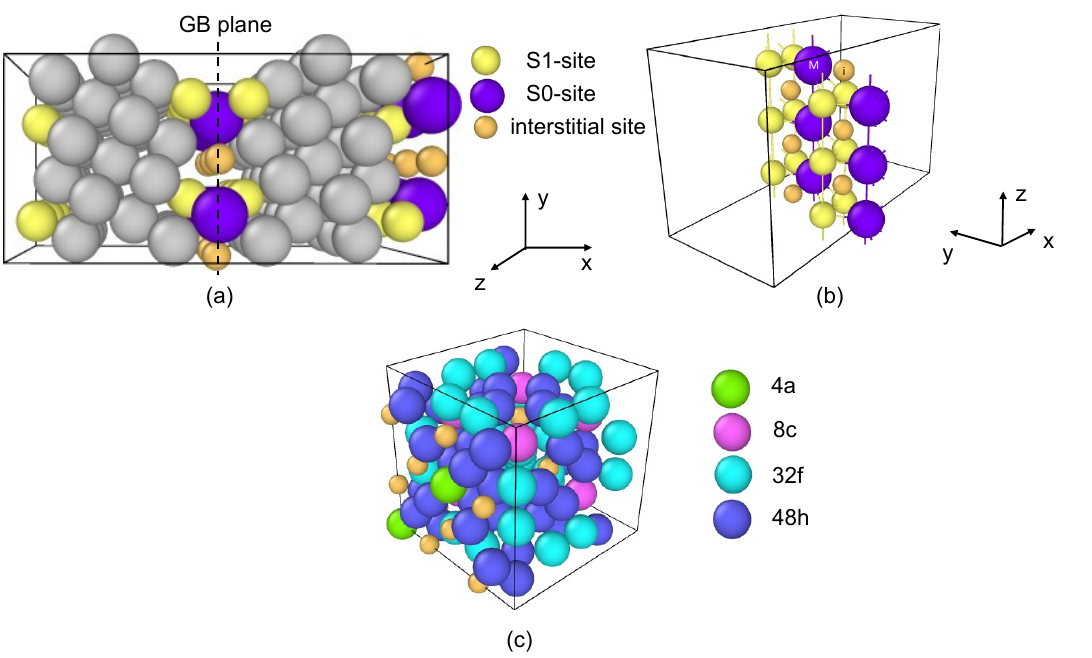
Figure 1. Atomic structure of Σ 5(210) fcc-Fe GB supercell ( a ), perspective view of the structural units ( b ) and M 23 (C,B) 6 supercell ( c ).